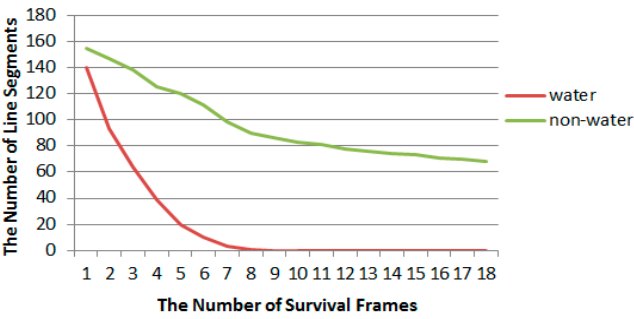
Figure 5. Survival frames statistics of line segments in water and non-water area; the red and green respectively correspond to the water and non-water area.